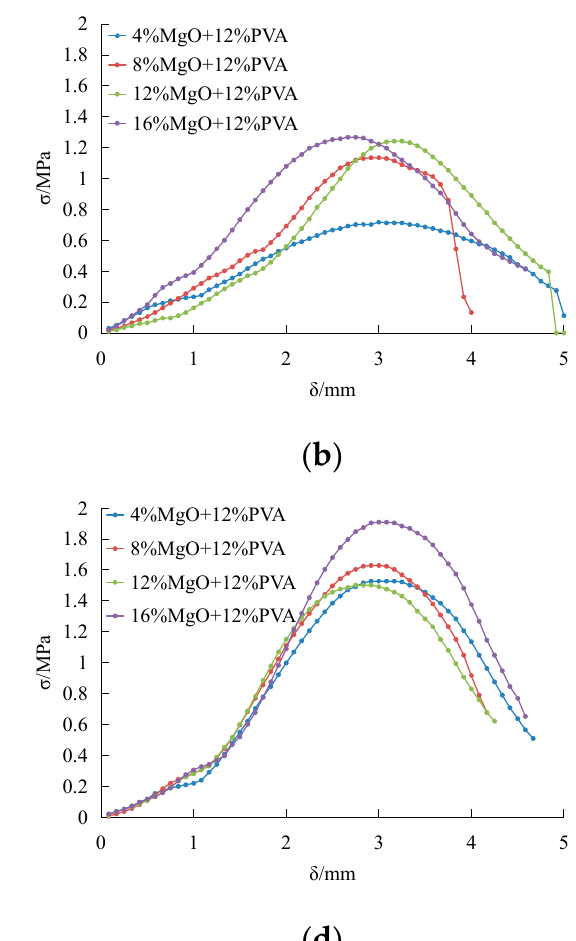
Figure 5. ( a ) 3 day; ( b ) 7 day; ( c ) 14 day; ( d ) 28 day. Stress–strain curve of PVA and activated mag- nesium oxide composite improvement.